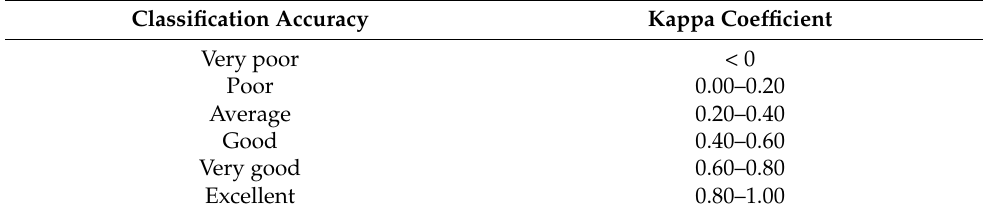
Table 1. Relationship between the kappa coefficient and classification